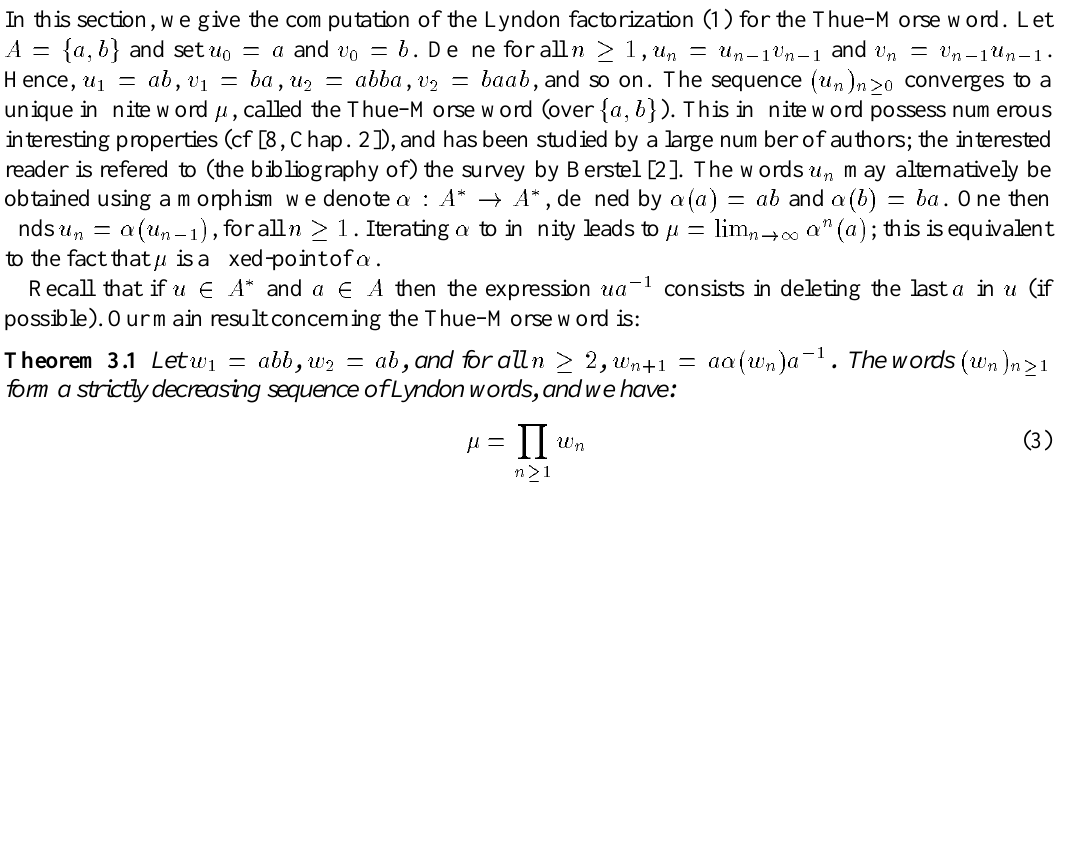
under (preserving standard ababb (cid:18)